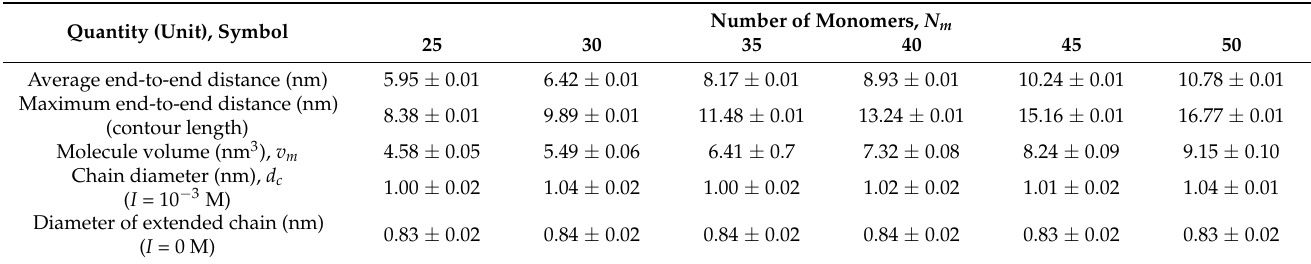
Table 2. The average and the maximum EtE length of the P-Arg molecule composed of 25, 30, 35, 40, 45 and 50 monomers derived from MD